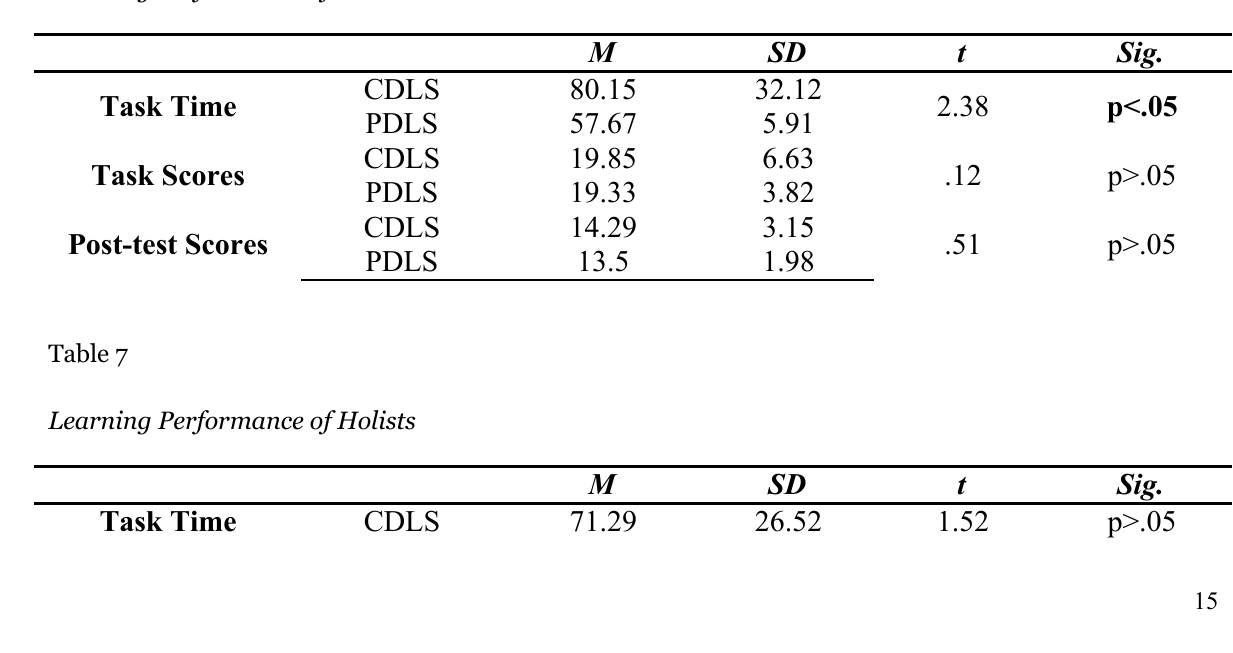
Learning Performance of Serialists